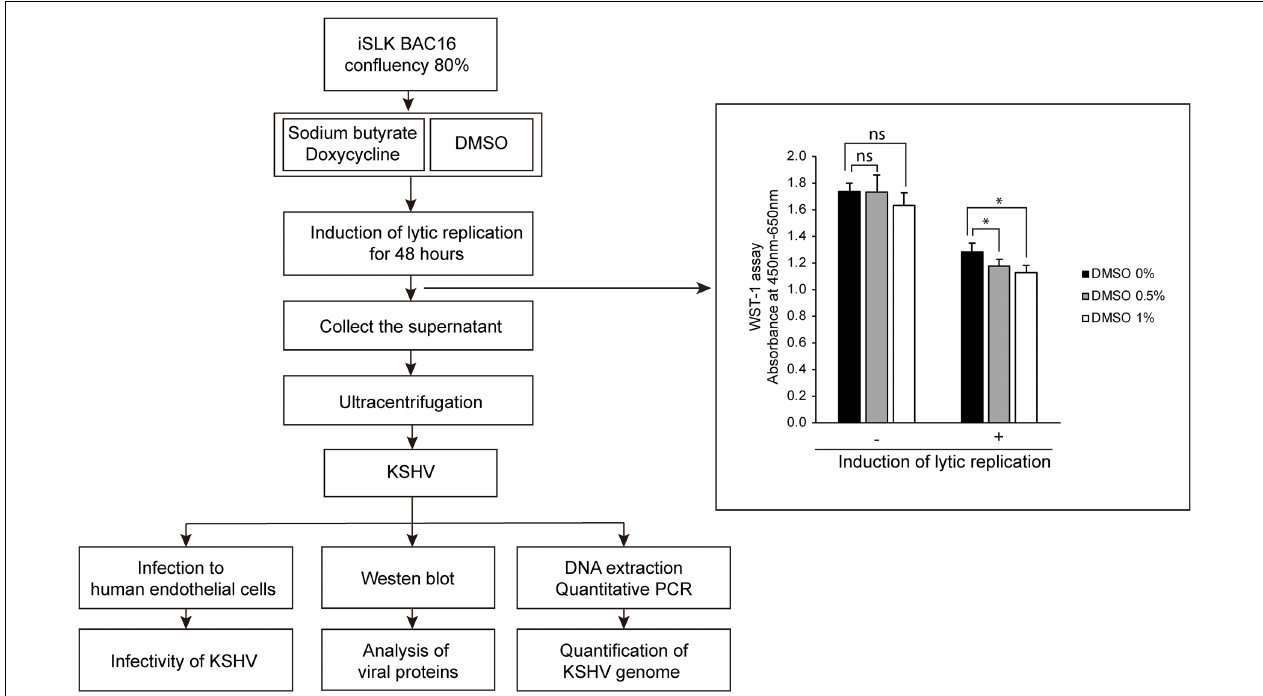
FIGURE 1 | Schematic diagram of the experimental processes and cell viability of iSLK BAC16 cells by treatment of DMSO. Lytic replication was induced by sodium butyrate and doxycycline for 48 h. DMSO was added into culture media together with sodium butyrate and doxycycline at various concentrations. During lytic replication, cells were treated with various concentrations of DMSO to investigate its effects on virus production. After DMSO treatment, cell viabilities were analyzed by WST-1 assay. Data are shown as the mean ± SD, n = 3, ns, not significant; * p < 0.05. The produced KSHV was extracted by differential centrifugation and analyzed by infection of HUVECs, western blotting, and quantitative PCR (qPCR).